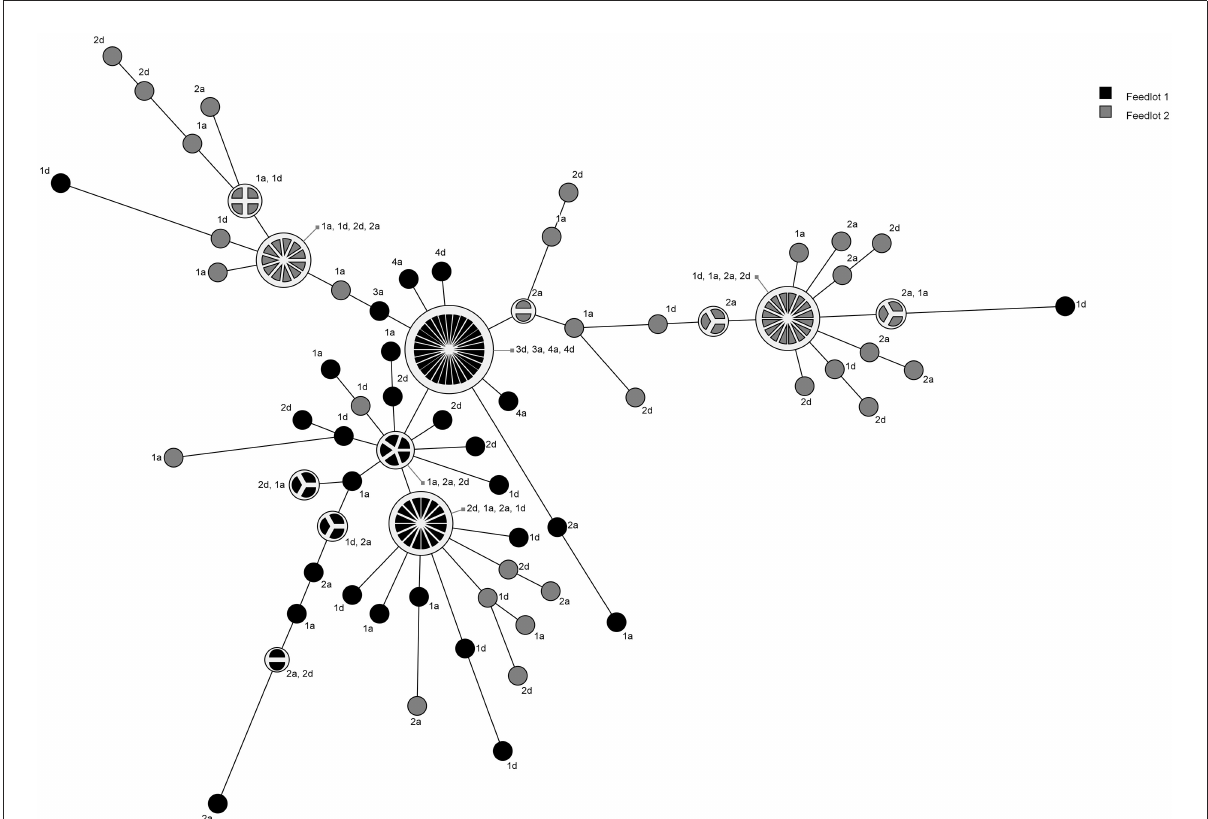
FIGURE4 Minimum spanning tree based on a similarity matrix generated from pulsed-field gel elctrophoresis profiles of P. multocida isolates collected from cattle in Groups 1 and 2. Distance between isolates indicates the similarity. Shading indicates group of animals the bacteria were isolated from (black = Group 1, gray = Group 2). Numbers refer to sampling times (1 = day 0, 2 = day 2, 3 = day 9, 4 = day 30). Letters represent the treatment (D, direct transport; A,